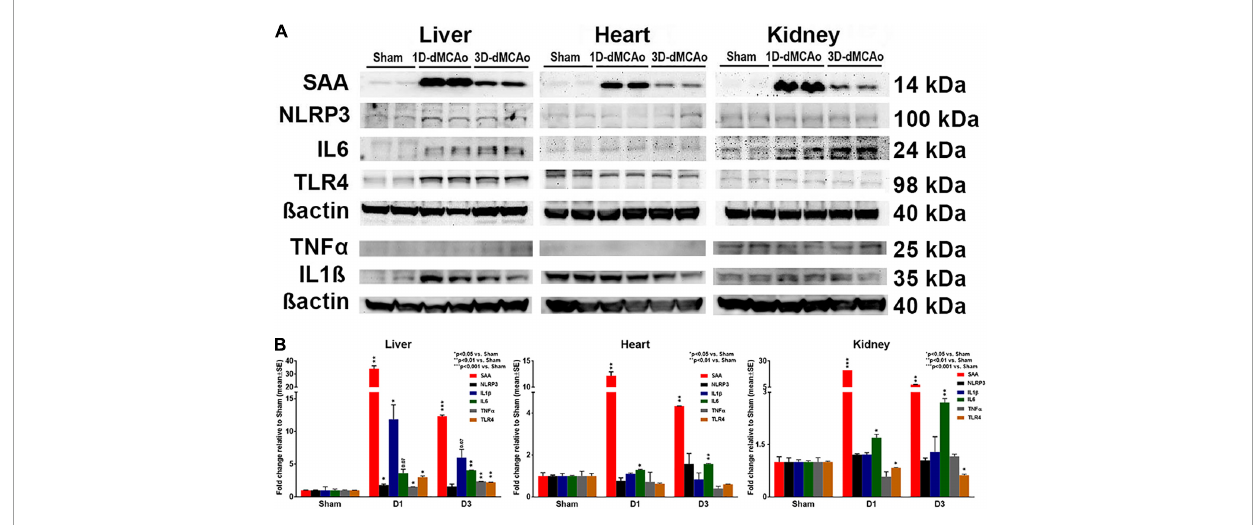
FIGURE3 T2DM-stroke induces liver immune-response earlier and stronger than in other peripheral organs. (A,B) Western blot was used to measure the expression of inflammatory factors, cytokines, and acute phase response related proteins at 1 and 3 days after stroke in T2DM mice. Stroke in T2DM mice induces earlier and higher cytokine and acute phase response protein expression such as SAA, NLRP3, IL1 β , IL6, TNF α and TLR4 in the liver compared to heart and kidney. The bands correspond to the precursor form for IL1 β and TNF α . n = 3/group.